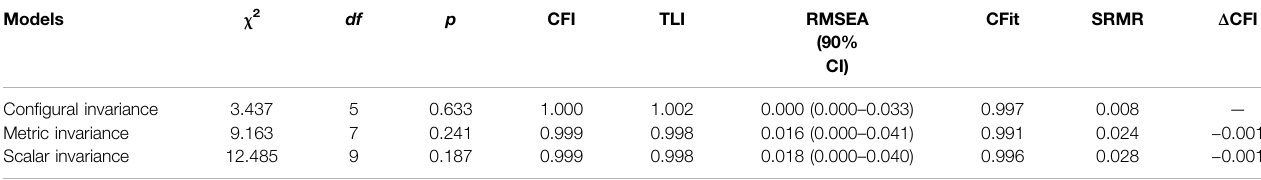
TABLE 1 | Tests of longitudinal measurement invariance of satisfaction of the need for relatedness. Models